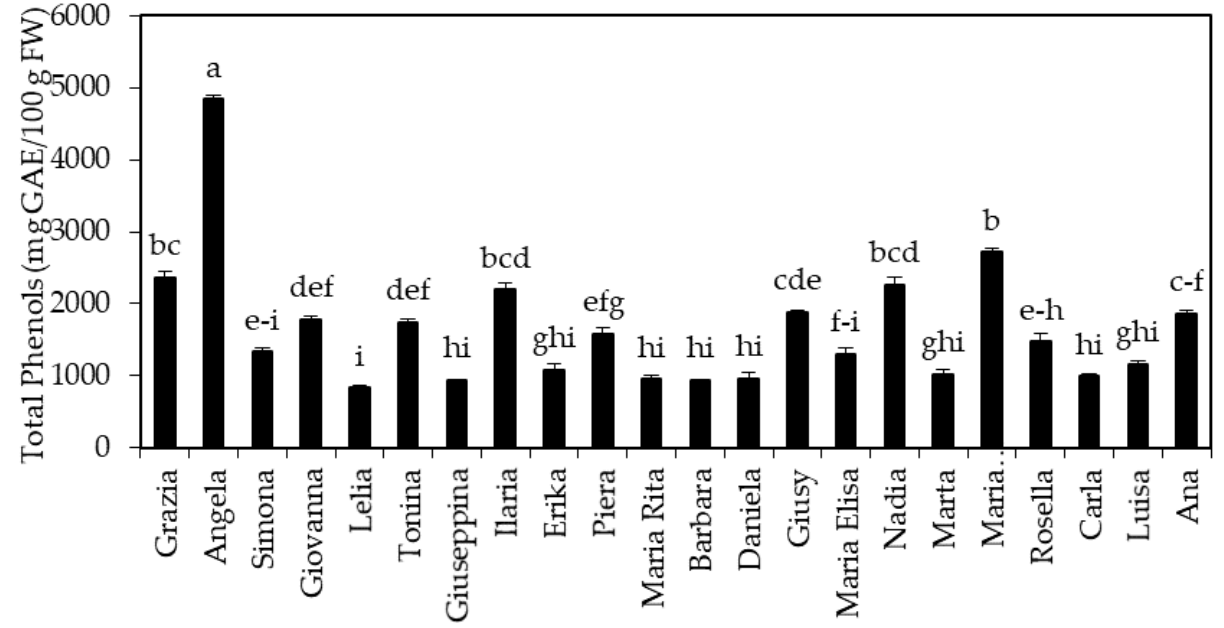
Figure 2. Total phenols content in berries of 22 myrtle cultivars. The results are expressed as means and standard deviation of three biological replicates. Histograms labelled with different letters indicate values significantly different ( p < 0.05) according to the Tukey test. Hyphen separate a continuous range of letters.